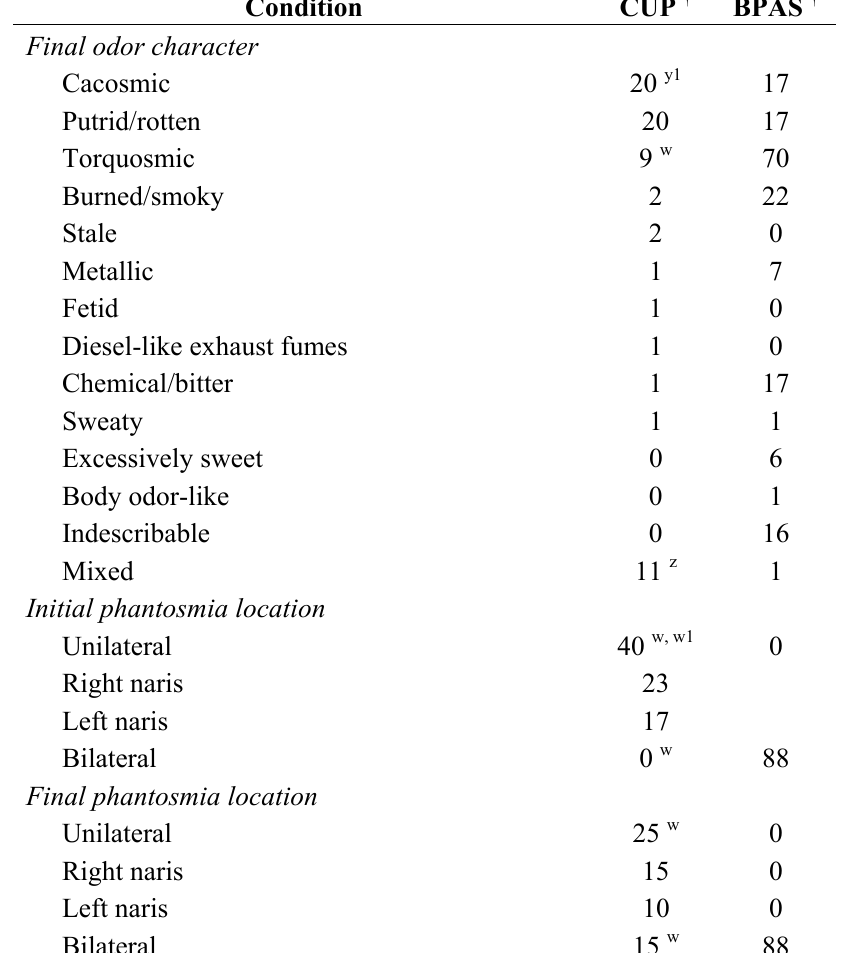
Table 2. Odor character of patients with